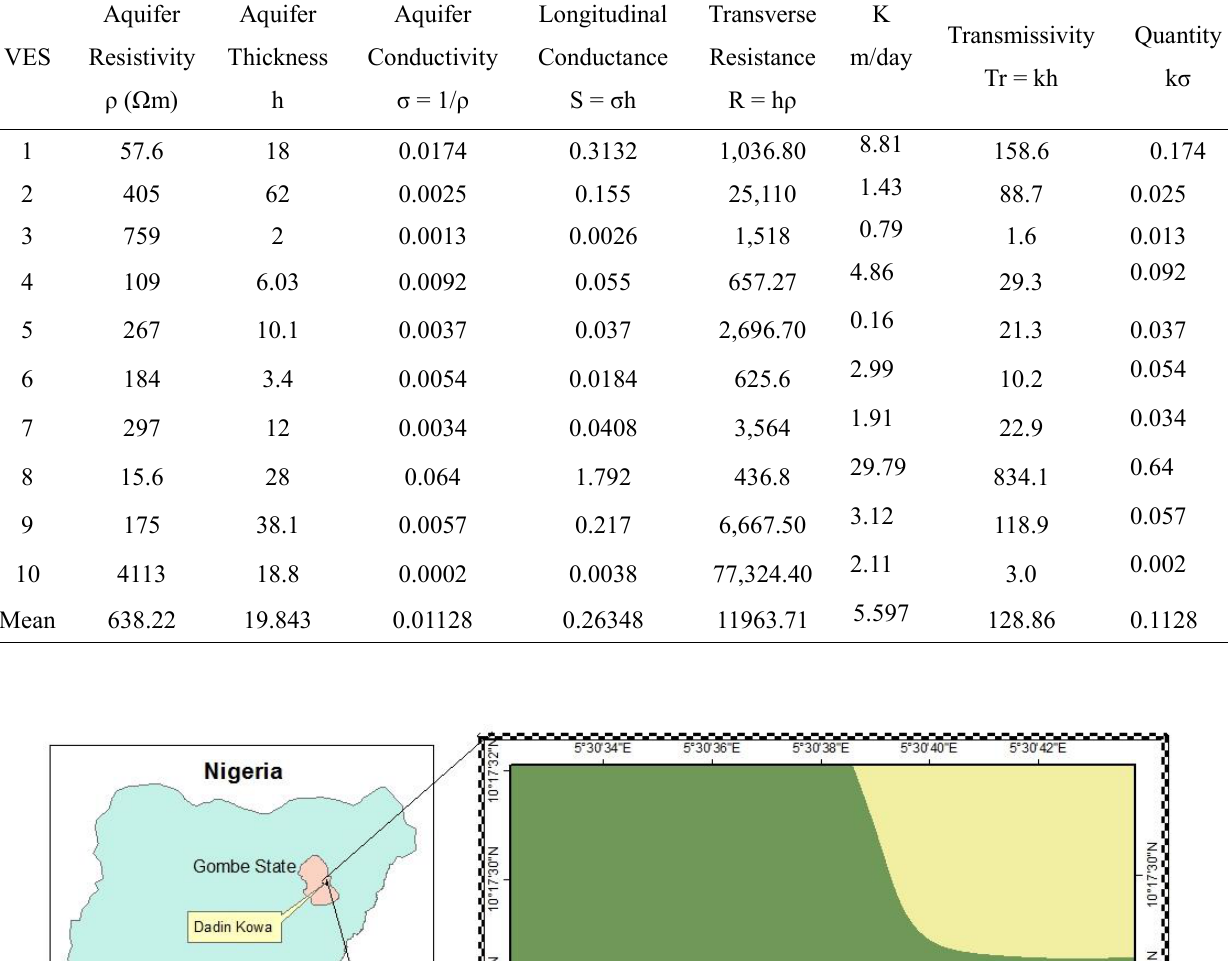
Dar Zarrouk Parameters at Alluvial Floodplain of River Dadin Kowa.